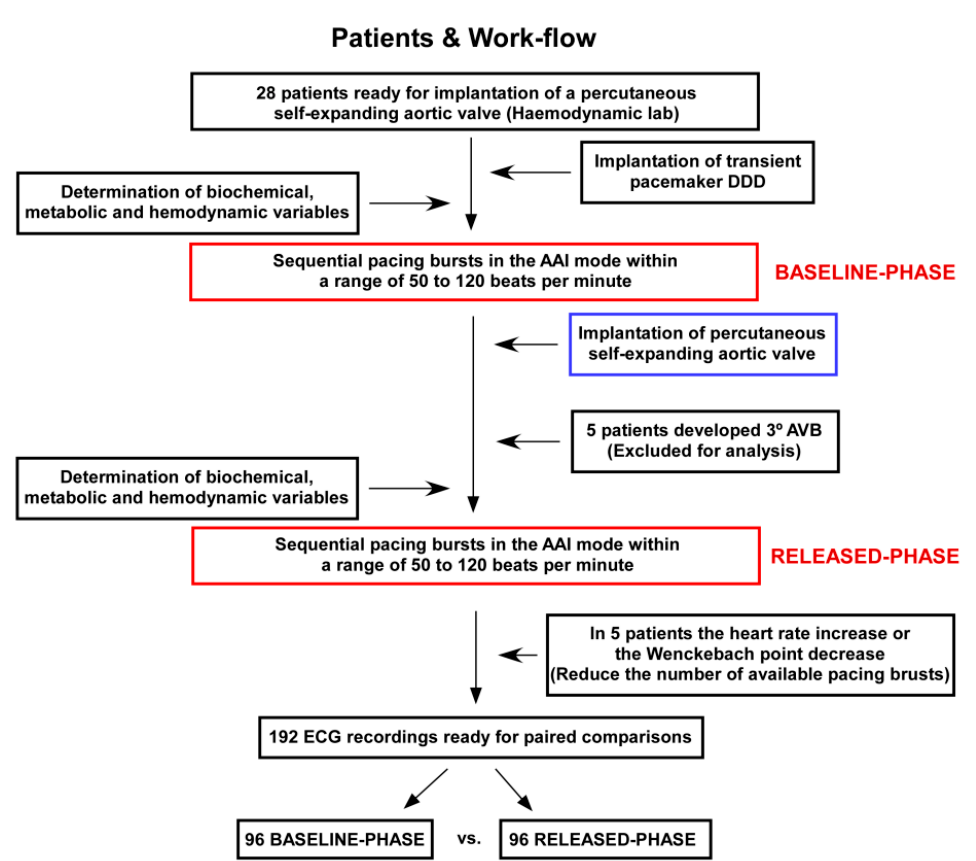
Figure 1. Flow-chart of patients included for analysis and experimental protocol.